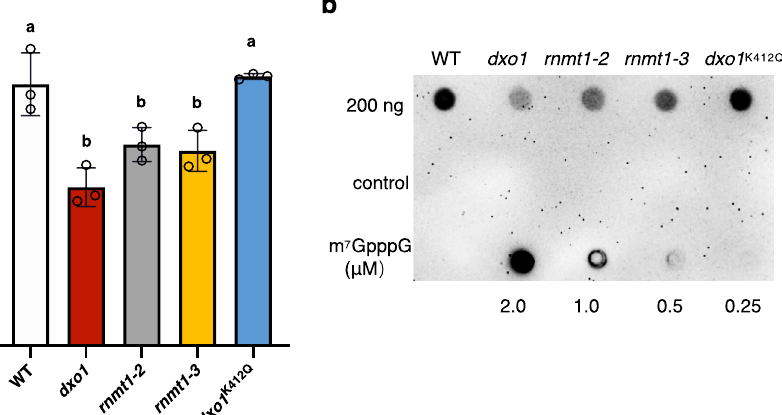
Fig. 5 | RNMT1 and DXO1 function in RNA cap methylation in vivo. a Quanti fi cation of G-capped and m 7 G-capped RNAs in WT, rnmt1-2, rnmt1-3, dxo1 , and dxo1/DXO1 K412Q by mass spectrometry. Caps of poly(A)-enriched mRNAs (4 μ g) from 4-week-old plants were hydrolyzed by the mRNA Decapping Enzyme to releasem 7 GDPorGDPformassspectrometryanalysis.ThemRNAsampleswithout the enzyme treatment were used as a negative control. Different letters indicate signi fi cant differences by one-way ANOVA, Tukey ’ s test ( p <0.05). Data are